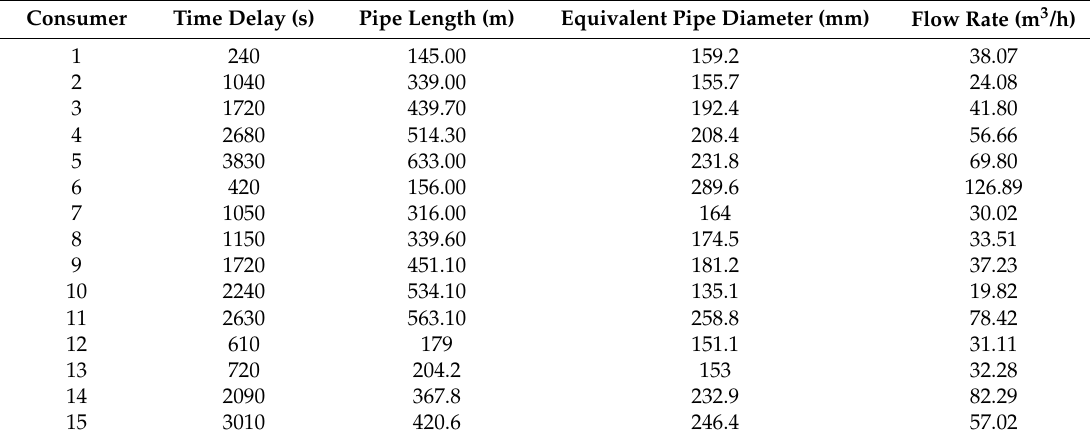
Table 7. Sensitivity analysis of pipe length and pipe diameter.